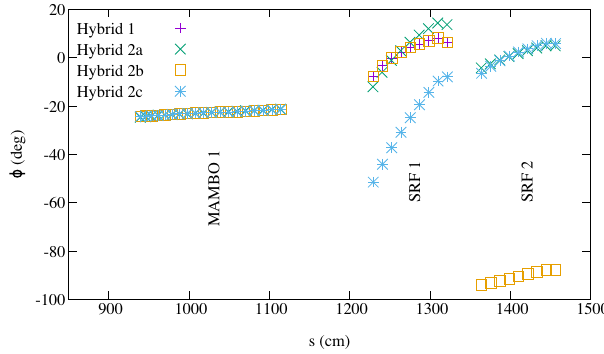
FIG. 6. Beam phases of the two versions of the hybrid MAMBO. For the two-seater cryomodule several modes of operation are shown.